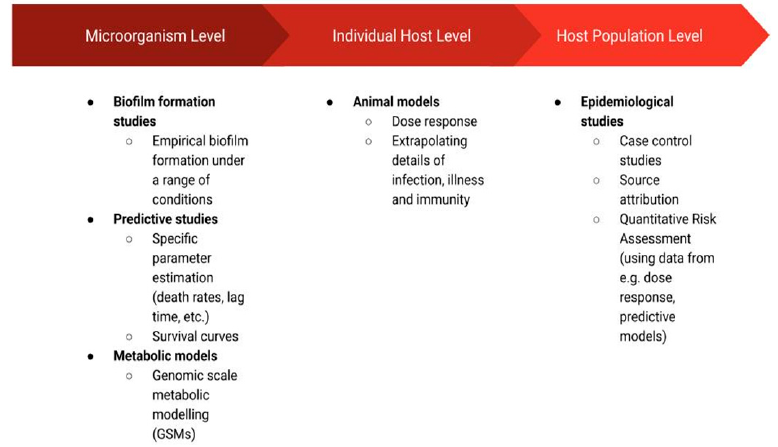
Figure 1. Schematic diagram of the disciplines discussed in this review, which were employed to study Campylobacter jejuni species.